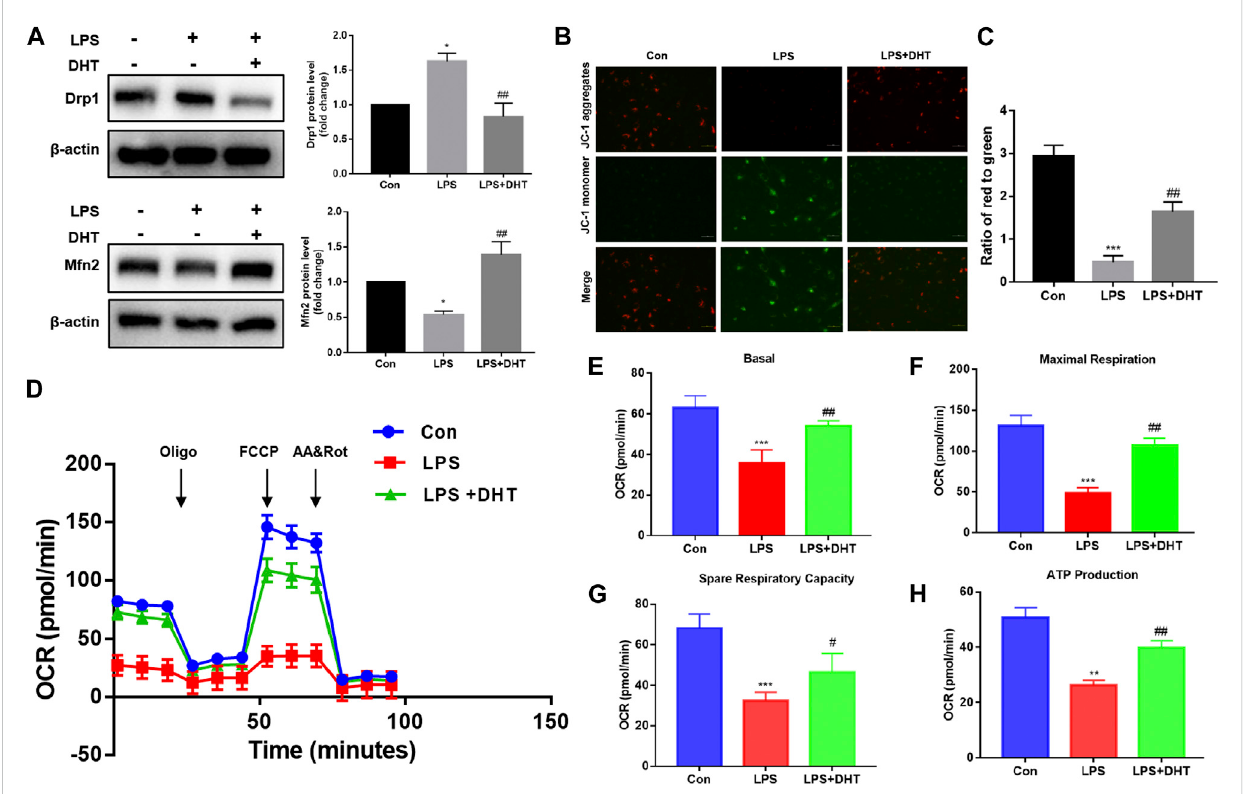
FIGURE 7 (A) Protein expression and quantitative analysis of Mfn2 and Drp1 were assessed by Western blot analysis and normalized to the intensity of β -actin (n = 3). * p < 0.05, ** p < 0.01 vs. Con, # p < 0.05, ## p < 0.01 vs. LPS. (B) MMP was detected using a JC-1 fl uorescent probe. Red fl uorescence represents aggregates, while green fl uorescence represents monomer. Scale bars: 50 μ m. (C) Quantitative data of the red to green fl uorescence intensity ratio in HK-2cells(n=3).*** p < 0.001vs.Con, ## p < 0.01vs.LPS. (D) OCRofHK-2cellsafteroligomycin(1.5 µM),FCCP(1.0 µM),androtenone/antimycinA (R&A at 0.5 µM) treatments was recorded. A mitochondrial stress test was conducted to detect mitochondrial energy metabolism and respiratory functioninLPS-inducedHK-2cellstreatedwithorwithoutDHT.Thebackgroundistheuntreatedcell. (E – H) Basalrespiration,maximalrespiration,spare respiration capacity, and ATP production in each group (n = 3). ** p < 0.01, *** p < 0.001 vs. Con, # p < 0.05, ## p < 0.01 vs.